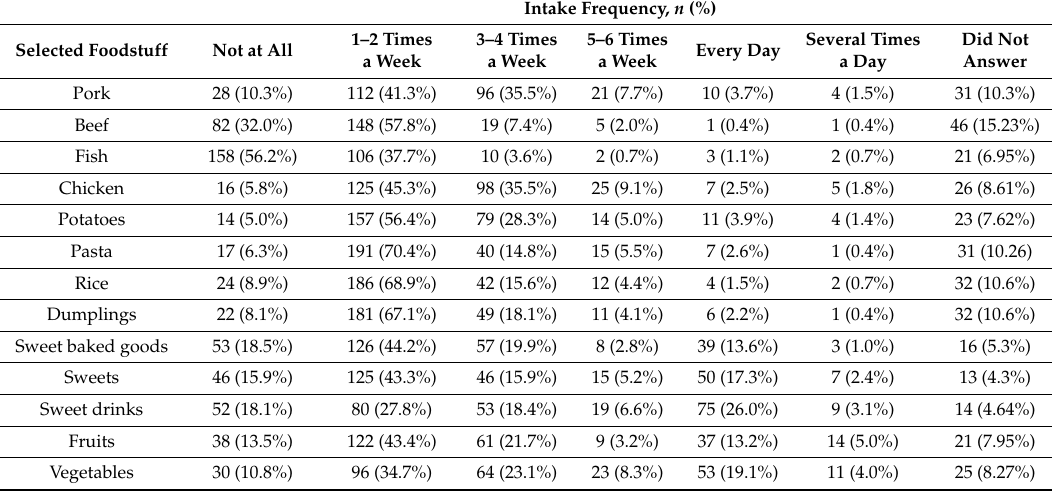
Table 1. Preference of selected foodstuffs in the Roma minority per week ( n =